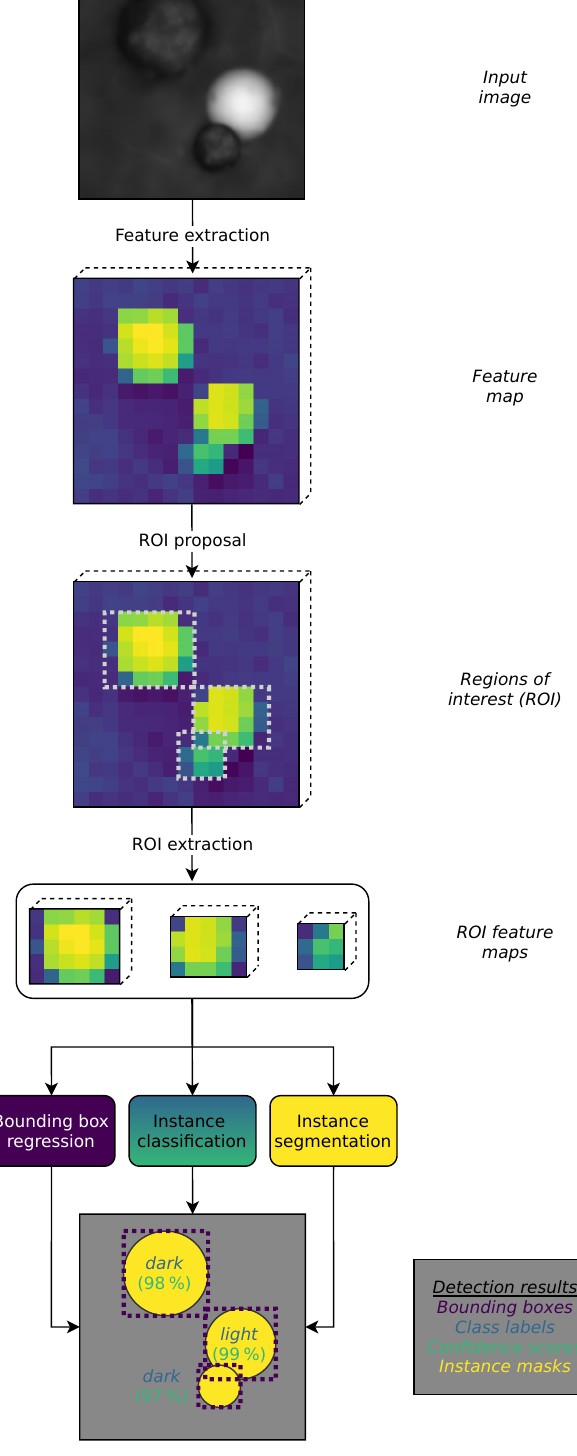
Figure 5. Illustration of the Mask R-CNN